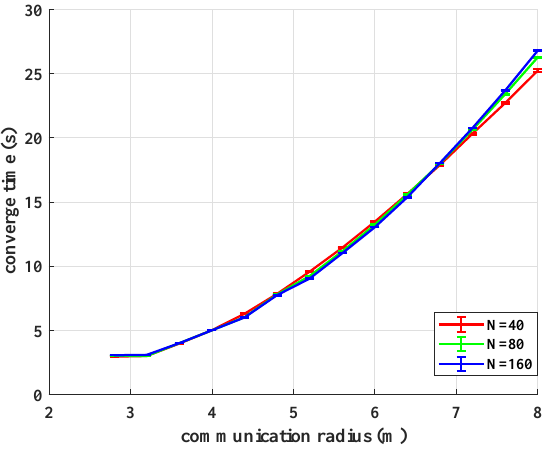
Figure 4. Time cost of flocking system